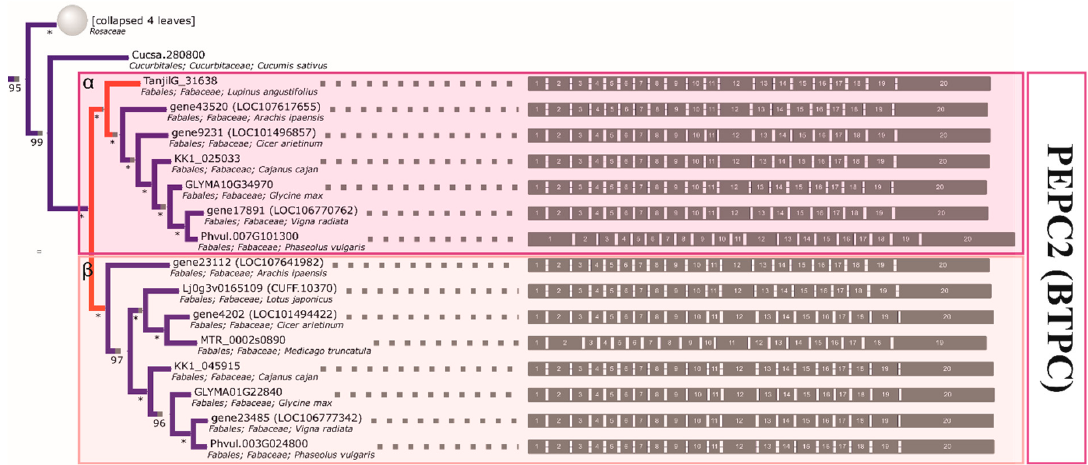
Figure 3. The reconstructed phylogeny of plant PEPC genes. A collapsed phylogeny tree was used in order to highlight Fabaceae family relationships.